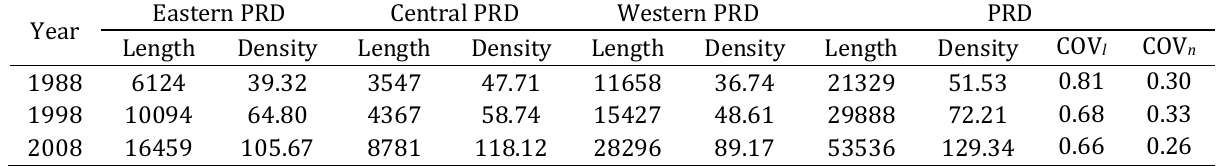
Table 1: Comparisons of network length and density in the PRD, 1988-2008